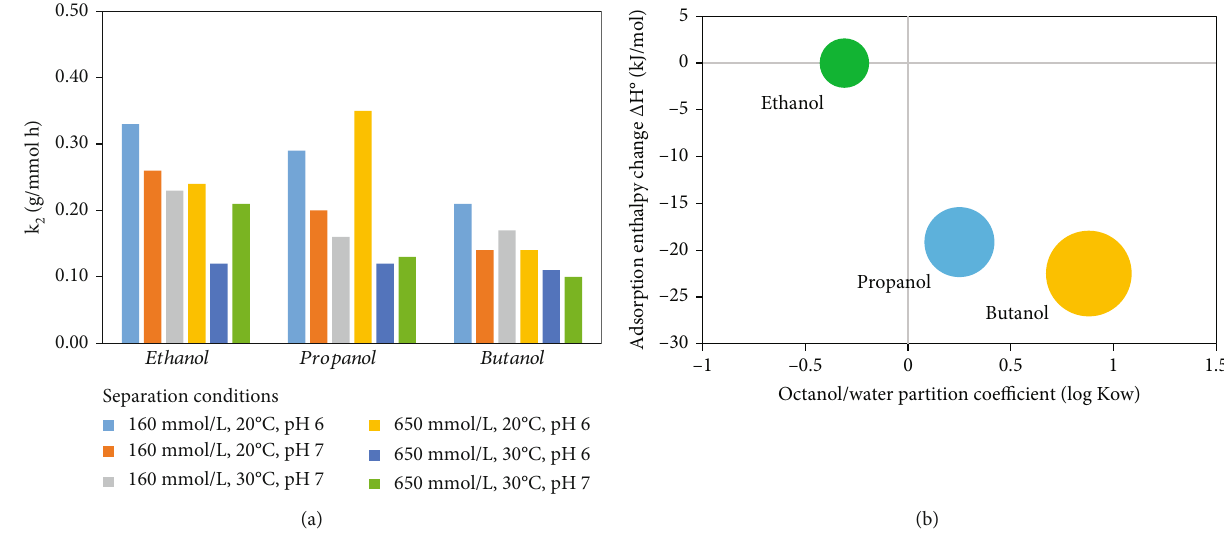
Figure 3: (a) Rate constants and (b) enthalpies for the adsorption of ethanol, propanol, and butanol from aqueous solution with bone char as